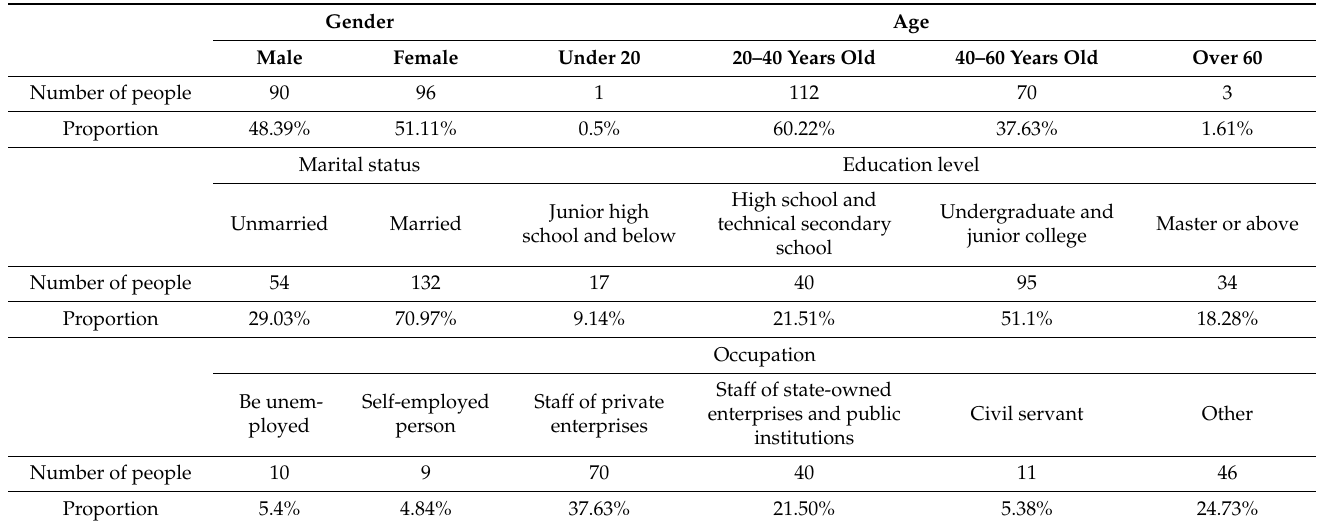
Table 2. Statistics of Basic Personal Information of